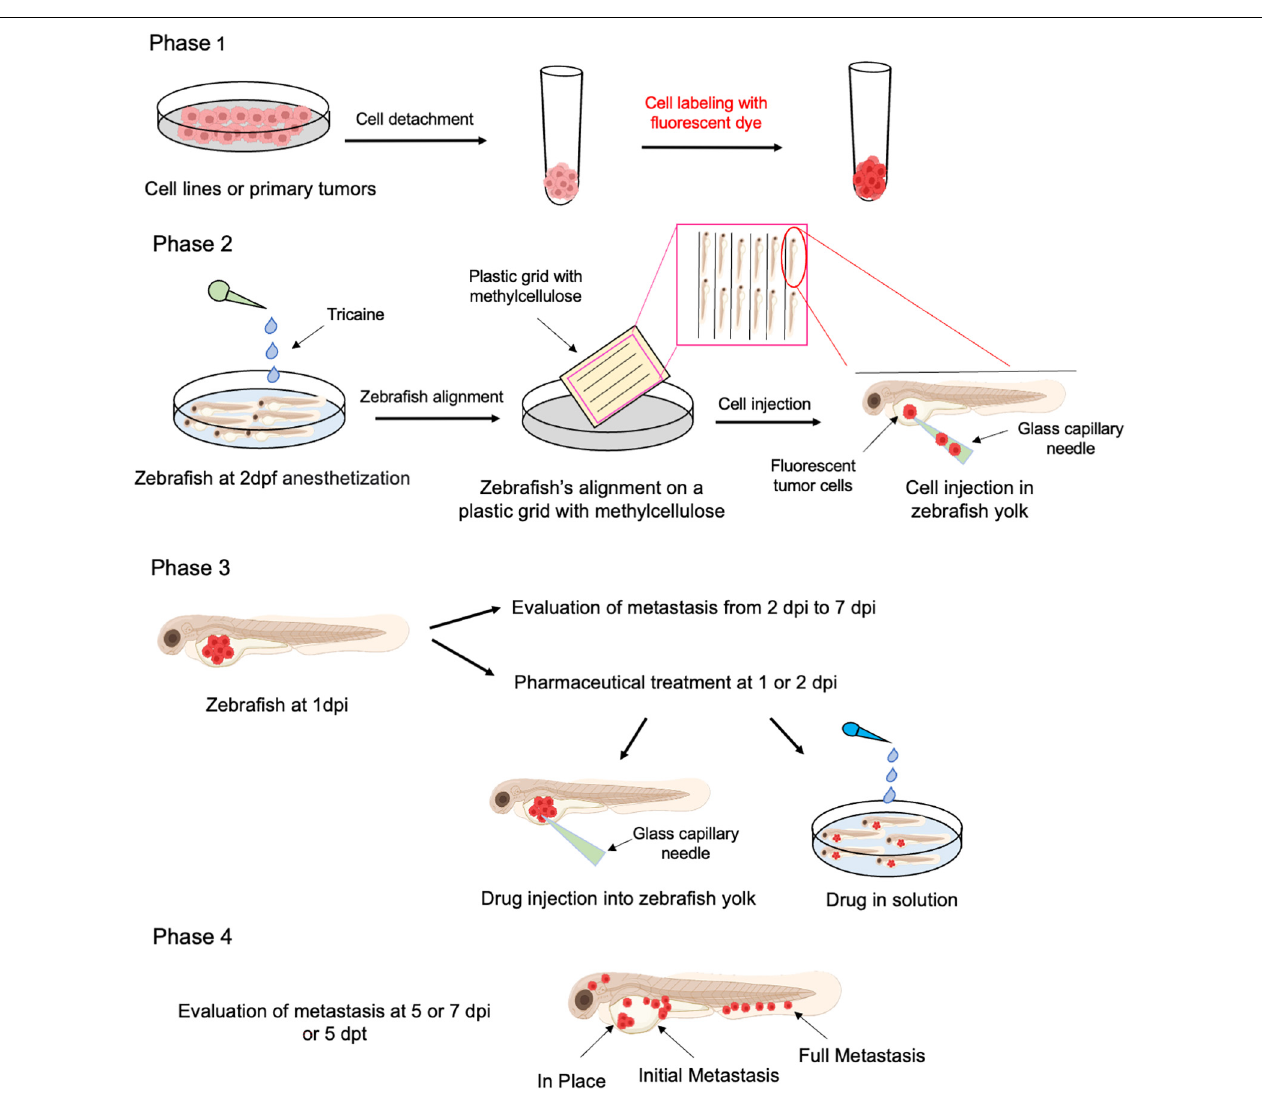
FIGURE 3 | Schematic representation of xenotransplantation protocol in Zebrafish. Freshly isolated human cSCC cells or cSCC cell line grown as adherent cultures are harvested by trypsinization and labeled with a fluorescent live cell tracer (Phase 1) . Labeled cells (around 50 cells/fish) are injected into the yolk of 2 dpf zebrafish larvae, previously anesthetized (Phase 2) . Fish could be treated by drugs/compounds either by injection or addition to fishwater (Phase 3) . Follow up with metastasis and proliferation of cancer cell evaluation is performed up to 7 dpi (Phase 4) . Dpf, days post fertilization; dpi, days post injection; dpt, days post